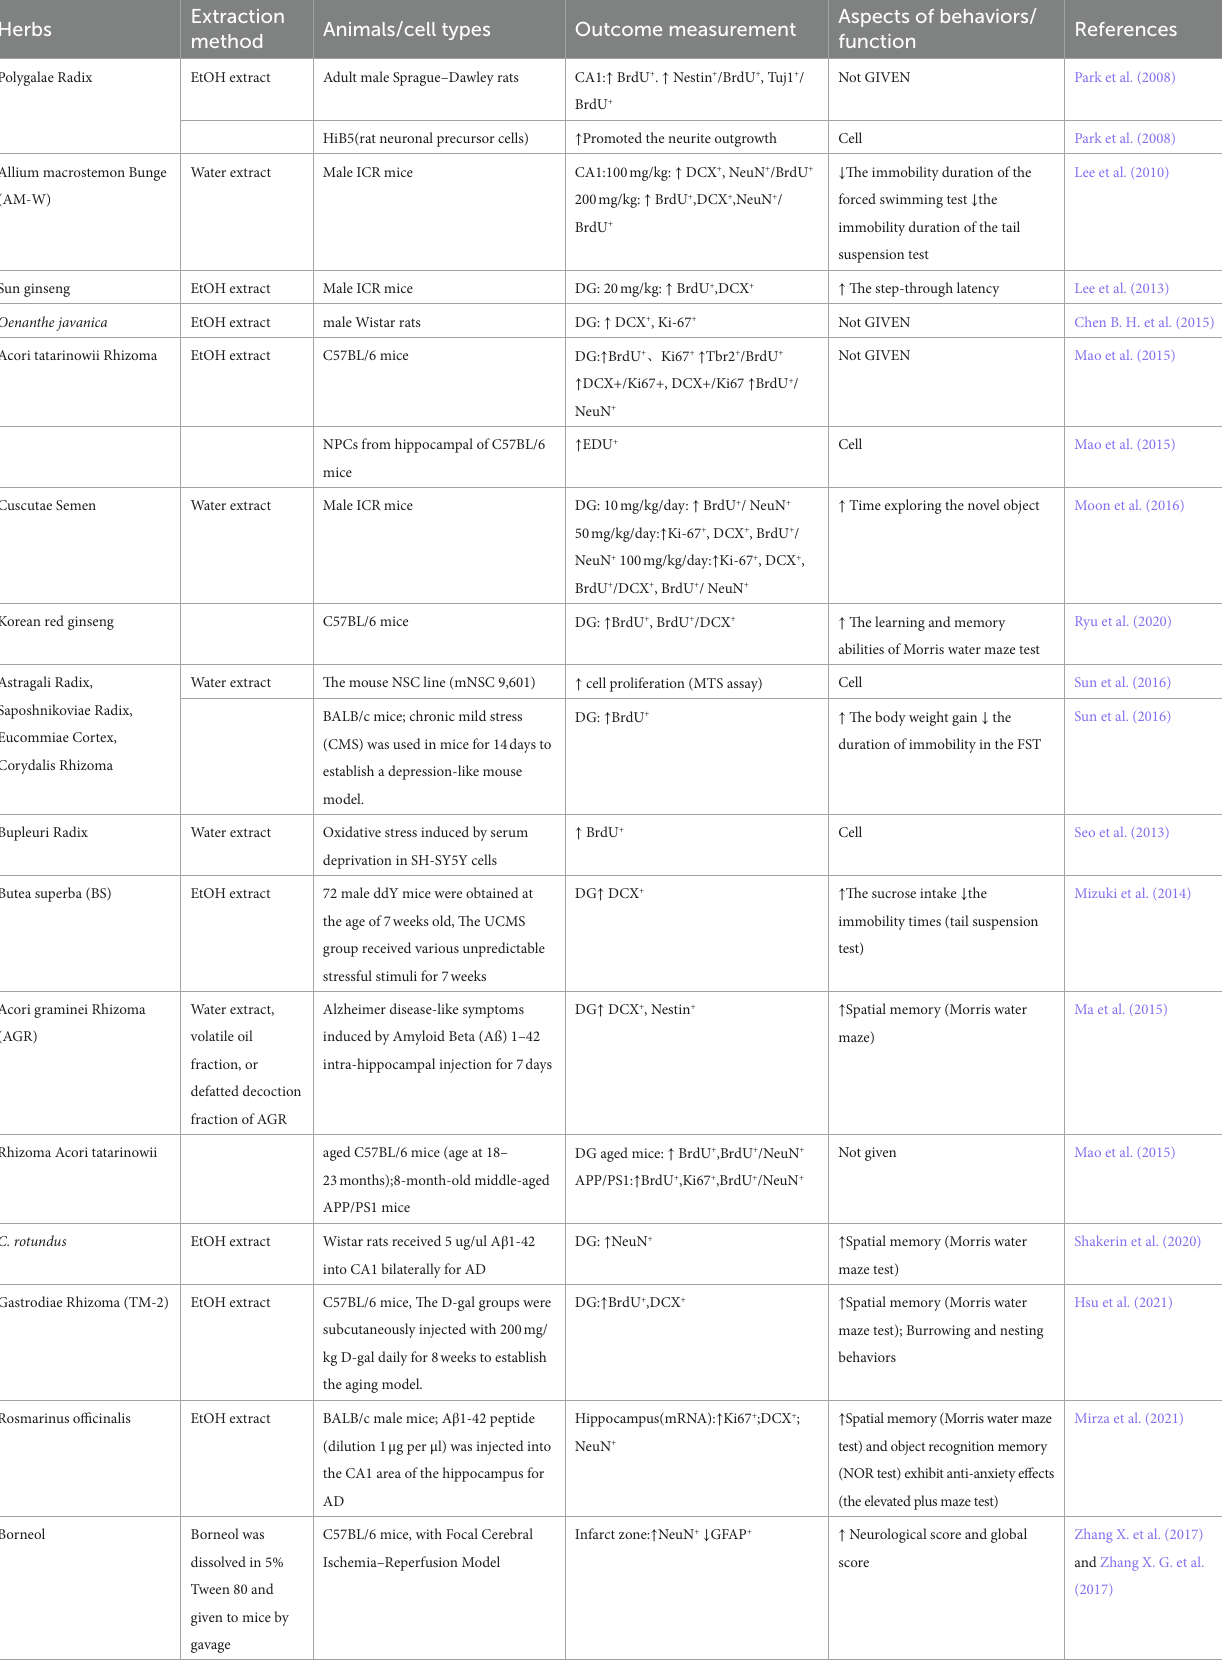
TABLE 2 Effects of CHMs on neurological conditions and adult neurogenesis.